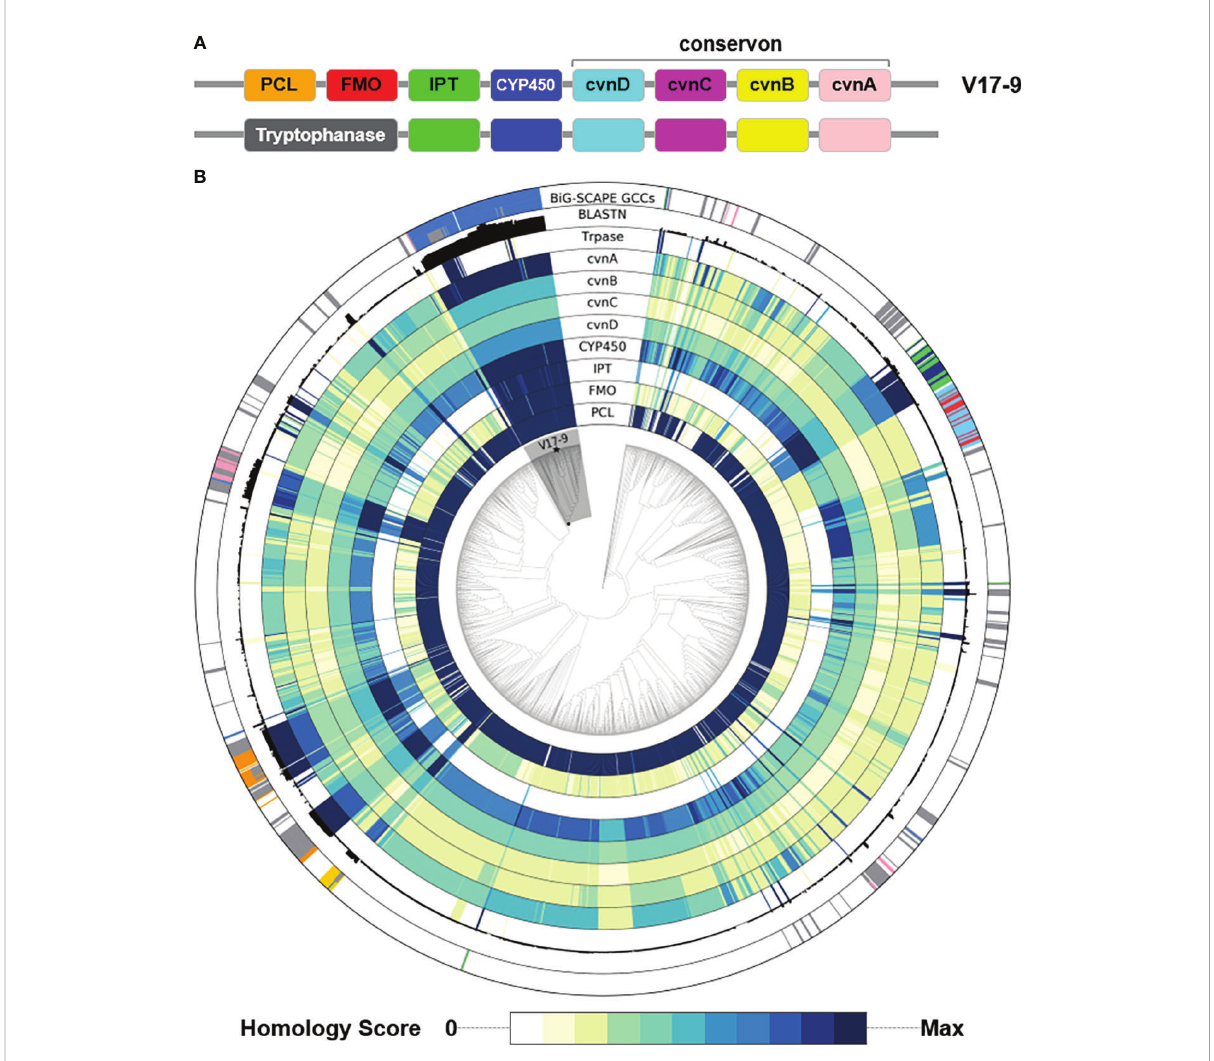
FIGURE 5 Distribution of key genes involved in the biosynthesis of prenylated indoles over a phylogenomic tree of 2,062 Streptomyces genome sequences. (A) The two types of gene structure. (B) For the nine tracks labeled with protein names, homology of each protein in the cluster was shown in the color gradient from white to dark navy. The more intense the color, the greater the homology with the corresponding query sequence. Homology score was calculated by – log10(E-value), where E-value of 0 was replaced with 1e − 200 to avoid in fi nity. BLASTN track shows the sum of bit scores of hits with Evalue < 1e − 20. The most peripheral track shows clan assignment from the BiG-SCAPE analysis shown in Figure 4. A monophyletic group including the V17-9 is shaded in gray. Strain V17-9 is indicated with a fi lled star mark at the terminal node. PCL, phenylacetate-CoA ligase; FMO, fl avin monooxygenase; IPT, indole prenyltransferase; CYP450, cytochrome P450; Trpase,